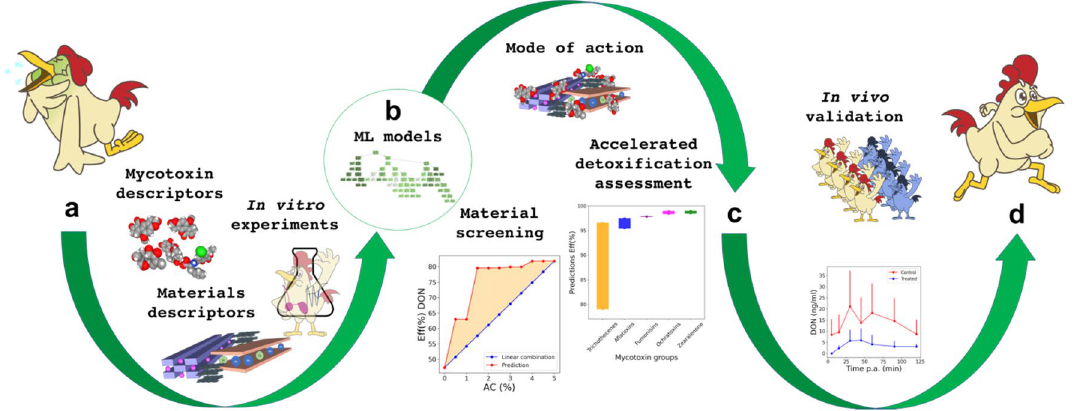
Figure 1. Workflow representation starting from selection of feature vector space ( a ) which describes the in vitro adsorption and efficiency (model targets). Machine learning models ( b ) trained on in vitro dataset providing tools for material screening, wide in vitro detoxification assessment, and mode of action capturing ( c ). In vivo validation of the findings extracted by our approach ( d ).